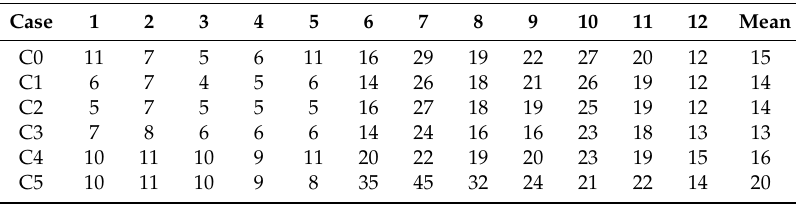
Table 1. Mean square errors between simulation and observation of storm surge levels in each period during Typhoon 7203 (unit: cm).